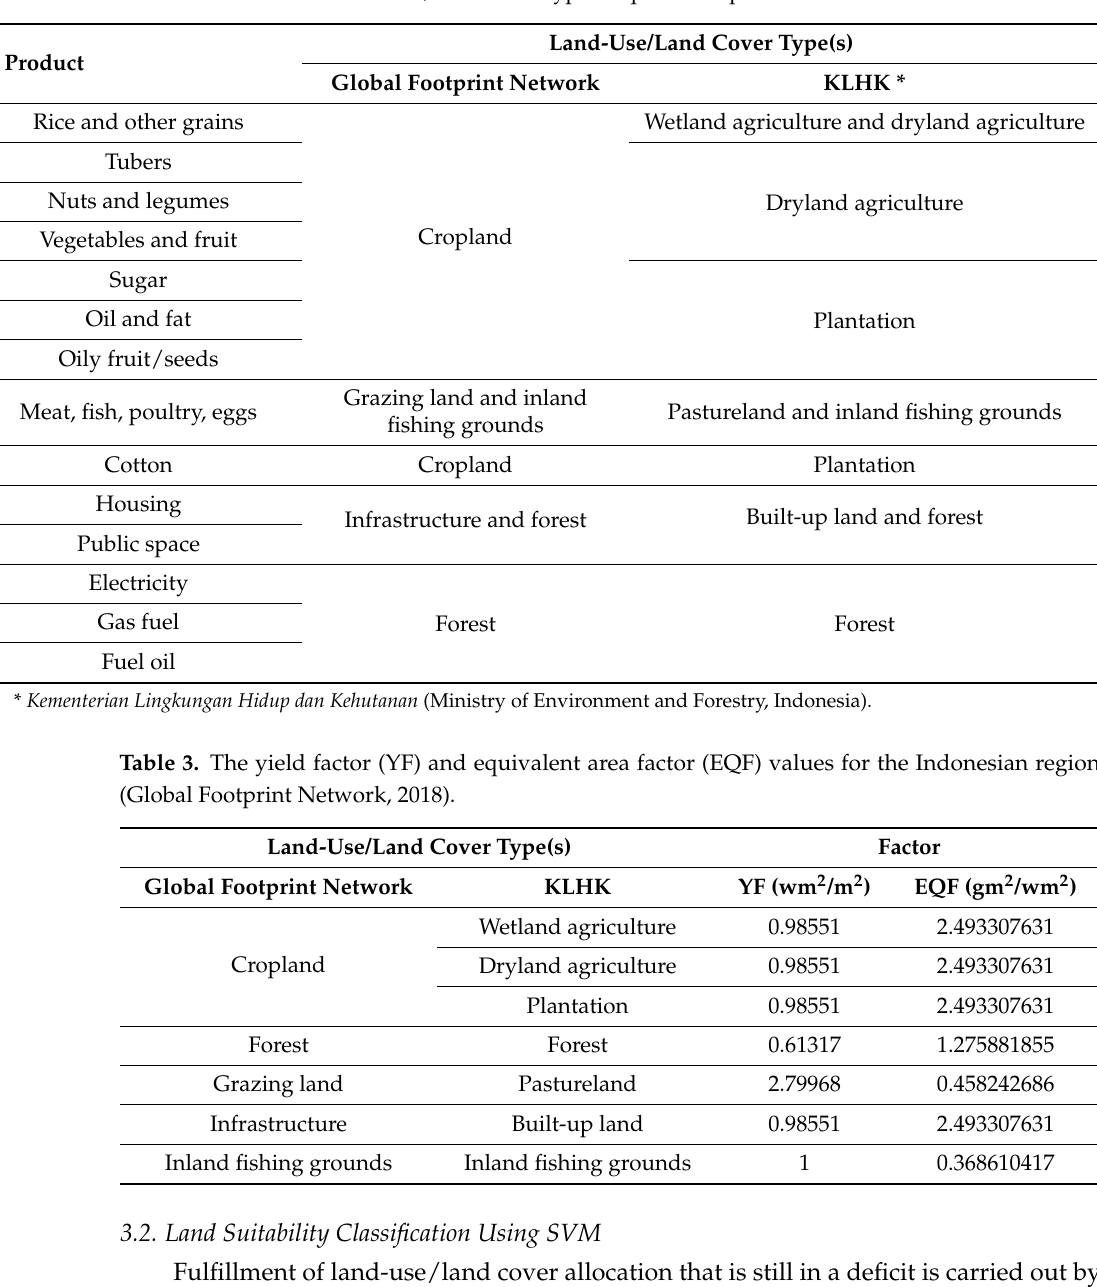
Table 2. The basic needs and land-use/land cover types required for production.